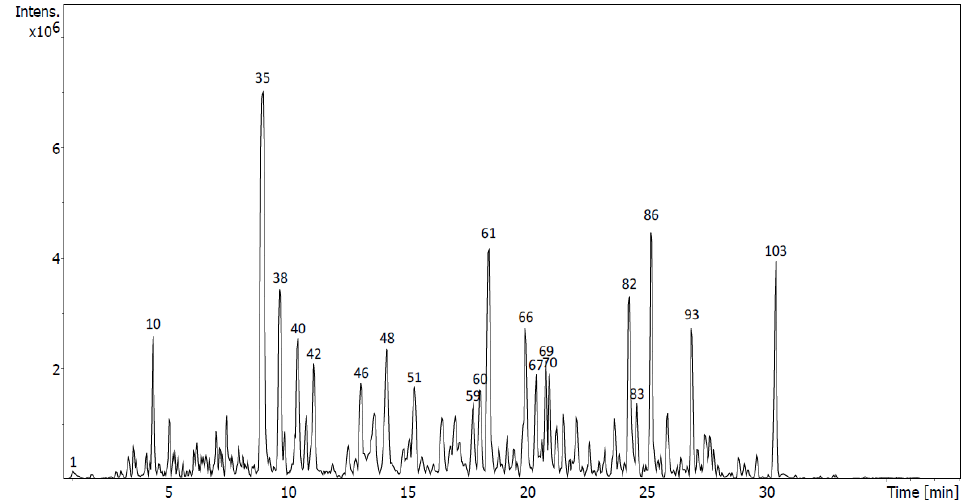
Figure 6. UHPLC-QToF chromatogram of sub-fraction D7 of U. gallii . Table 3. Flavonoids identified in targeted analysis via UHPLC-ESI-QToF of sub-fraction D7 of U. gallii (Rt = retention time, m/z = mass/charge ratio of the compound, mSigma = deviation in the isotopic pattern, Δ m/z = deviation in the mass ratio/charge measured in relation to the expected value).